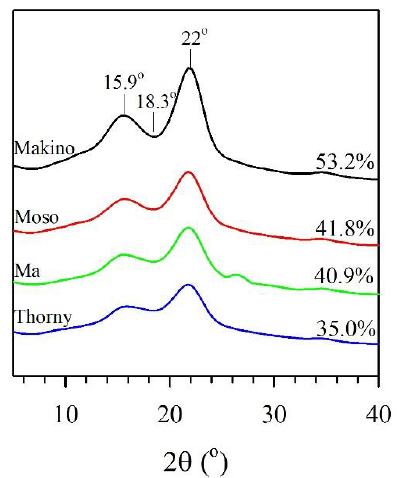
Figure 1. X-ray diffraction ( XRD) patterns and crystallinity indexes (CrIs) of various BFs. Figure 1. X-ray di ff raction (XRD) patterns and crystallinity indexes (CrIs) of various